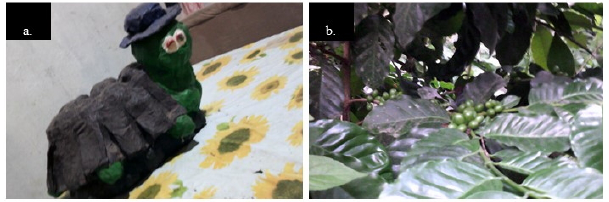
Fig. 5 . Photographic responses from Santa Rosa in response